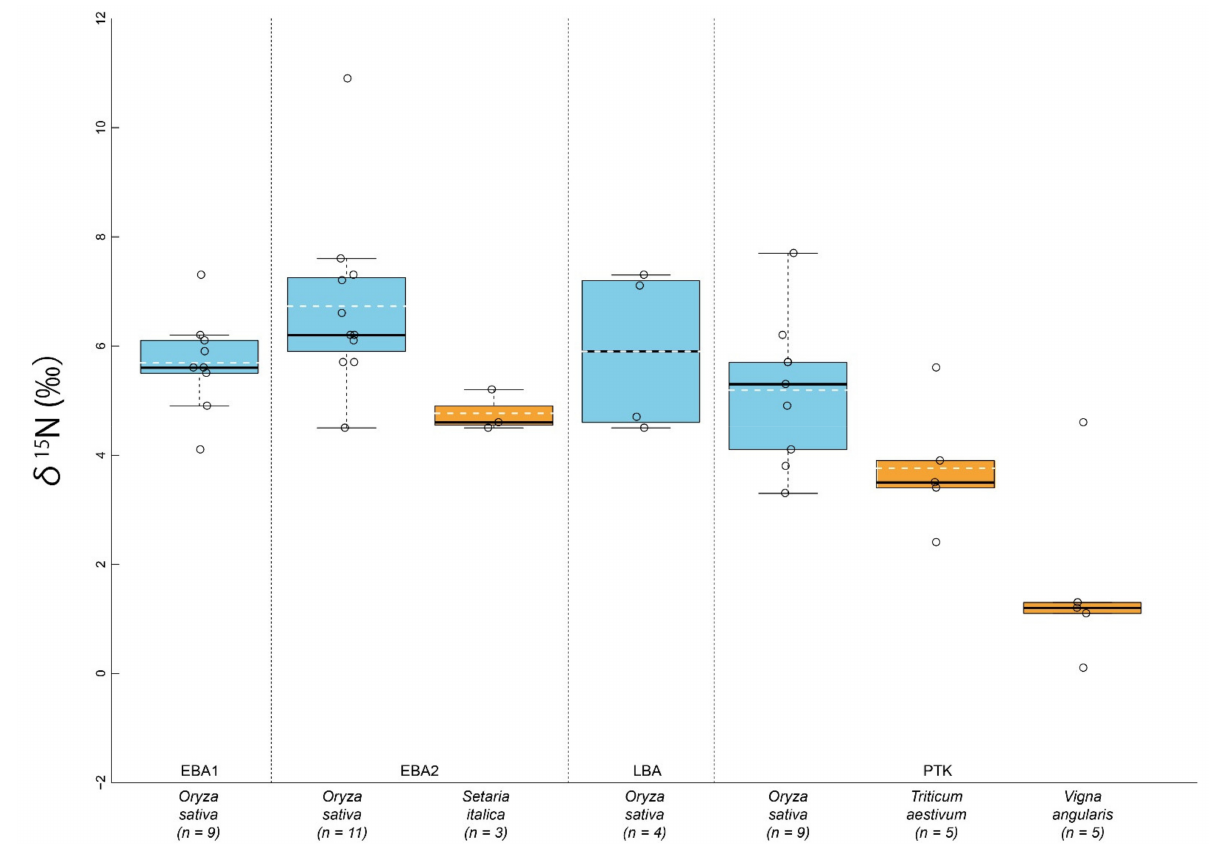
Figure 4. Boxplot comparing nitrogen stable isotope values among rice, wheat, and azuki bean in each period. Lower and upper box boundaries are 25th and 75th percentiles, error bars are upper extreme and lower extreme, respectively, the lines inside the box are the median, and broken lines are the mean